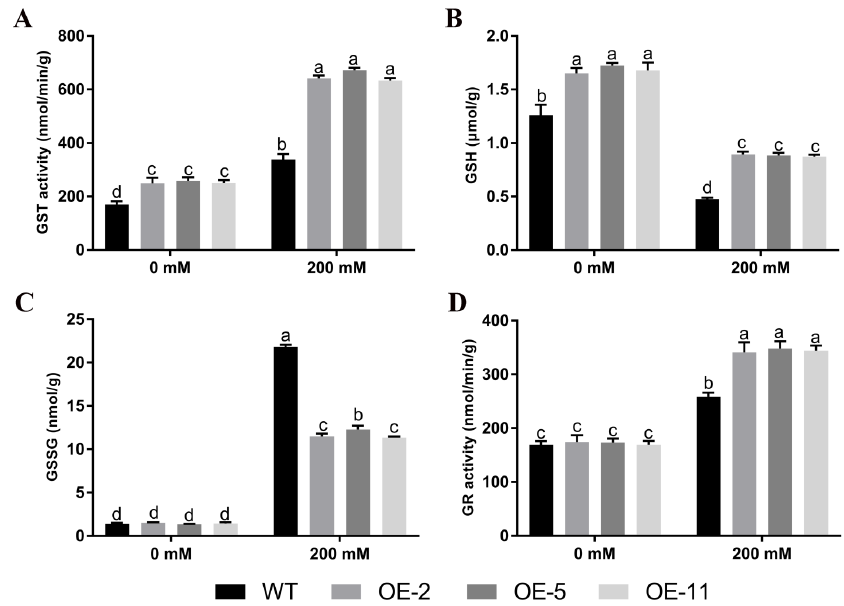
Figure 5. Glutathione pool composition and related enzymes. ( A – D ) Changes in GST ( A ), GSH ( B ), GSSG ( C ), and GR ( D ) contents of 15-day-old wild-type and transgenic Arabidopsis thaliana after 20